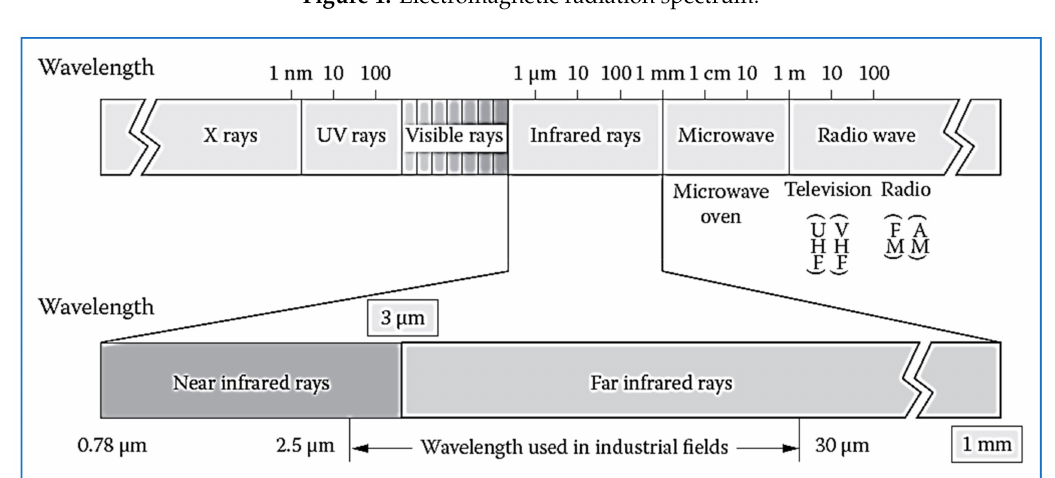
Figure 1. Electromagnetic radiation spectrum.